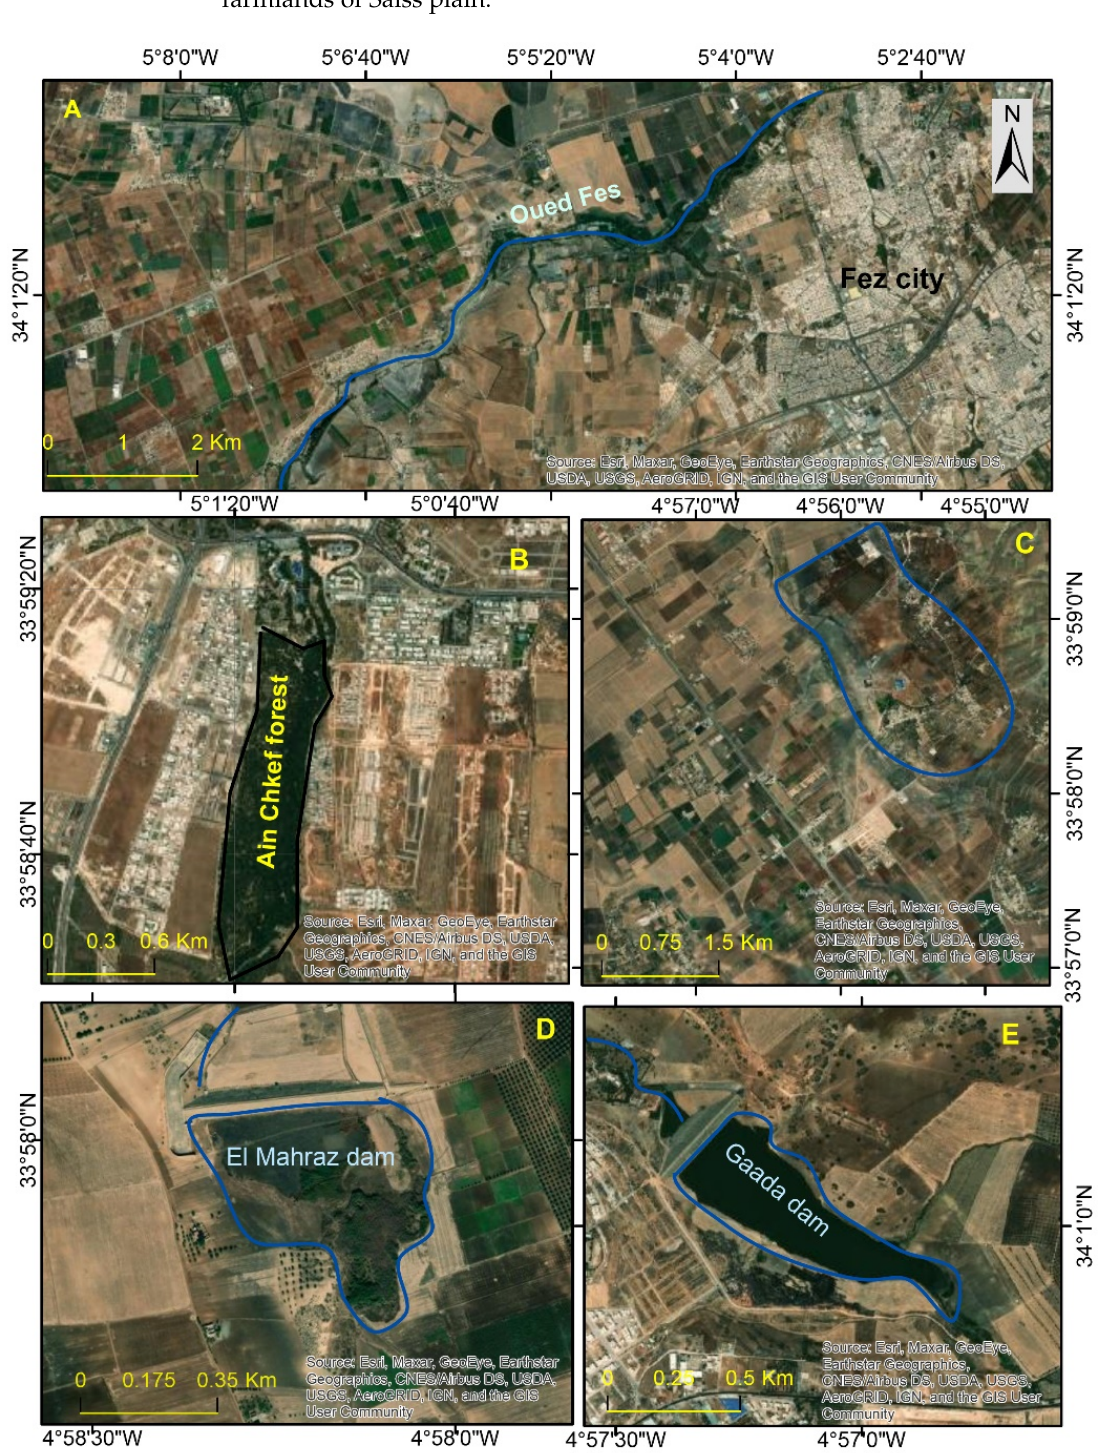
Figure 2. Studied sites: ( A ) Oued Fez; ( B ) Ain Chkef Forest; ( C ) Ain Bida Dump; ( D ) El Mehraz Dam; ( E ) Gaada Dam.